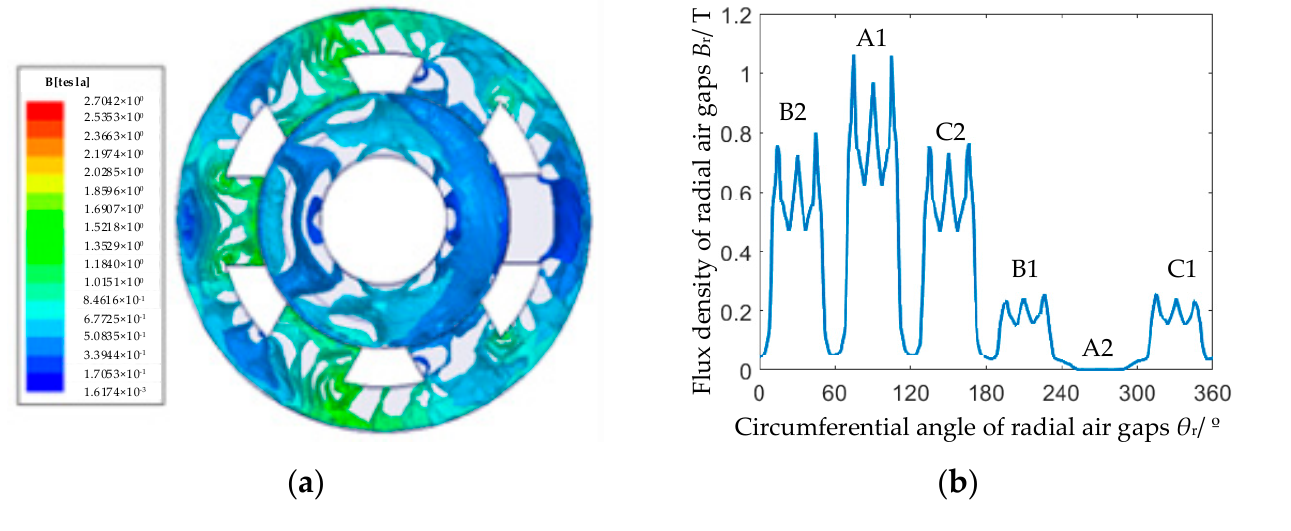
Figure 7. FE analysis results of radial flux density with maximum radial control current. ( a ) Flux distribution of radial stator and rotor. ( b ) Flux density in radial air gaps.